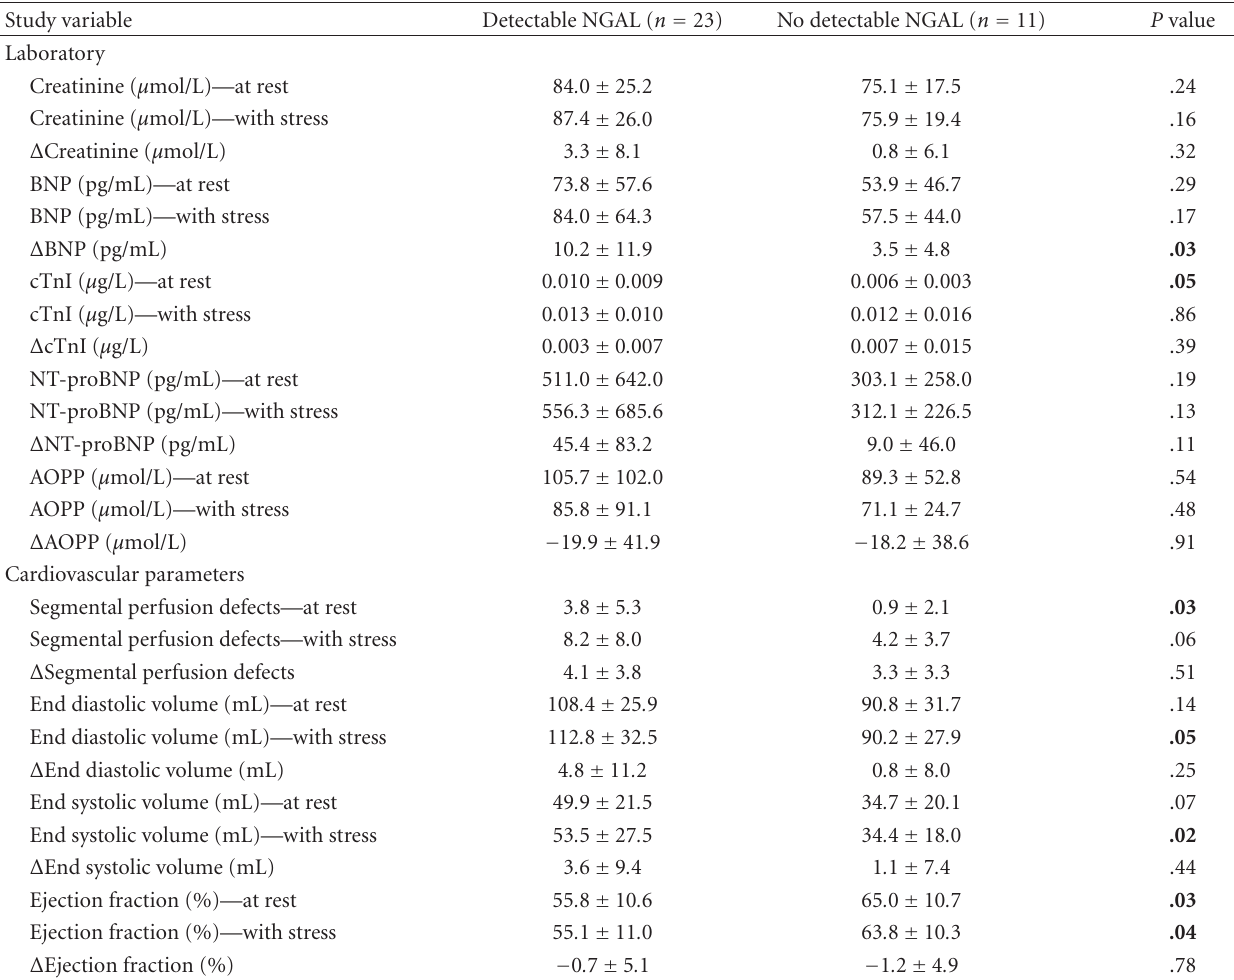
Table 3: Results between groups based on existence of detectable plasma neutrophil gelatinase-associated lipocalin (NGAL). Study